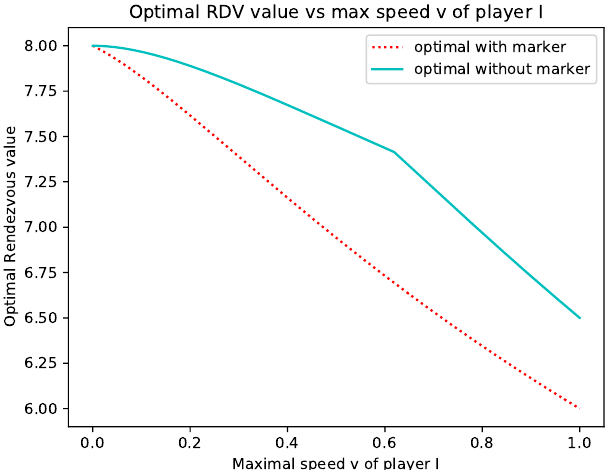
Figure 6. Optimal solutions with (18) and without marker. The slow player holds the